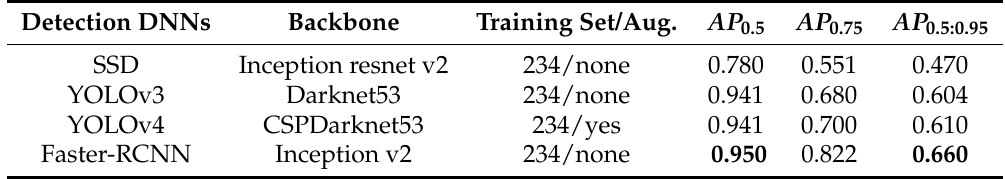
Table 4. Summary of evaluation of spike detection DNN models on PASCAL VOC ( AP 0.5 ) and COCO detection metrics ( AP 0.5:0.95 ), respectively. Best results are highlighted in